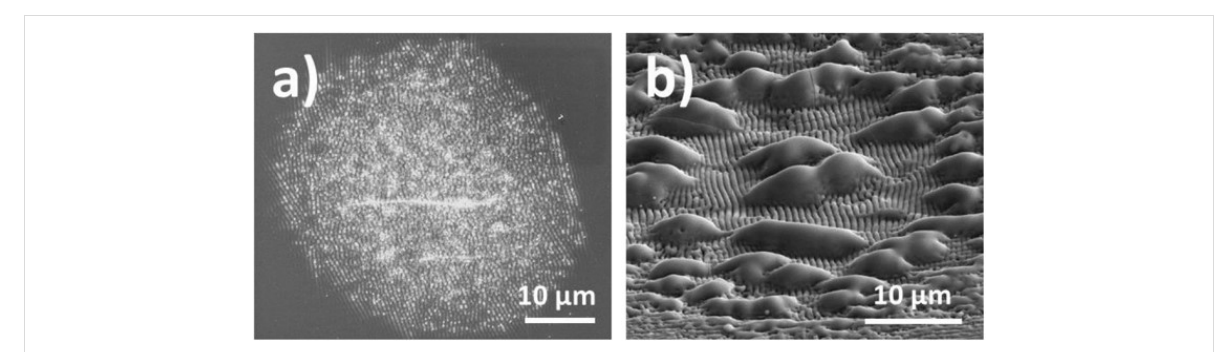
Figure 5: Scanning electron micrographs of laser-induced modifications on glass. Laser parameters: F = 1.63 J/cm 2 , N = 100 (a); 1.83 J/cm 2 , N = 30 (b). SEM tilting angle 0° (a), 52°